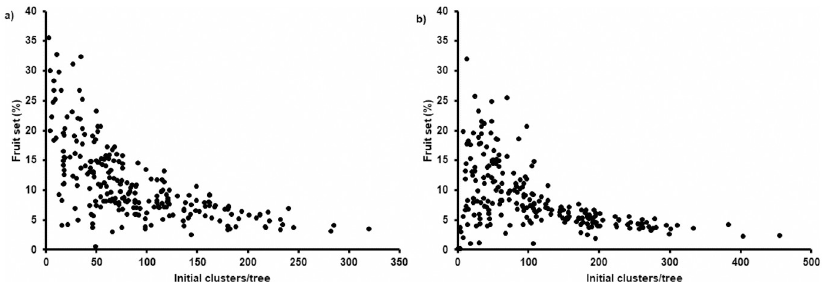
Fig 3. Fruit set (%, (number of fruitlets after June drop/number of flowers) � 100) per tree in function of the initial number of flower clusters on the trees recorded in 2019 (a) and 2020 (b).